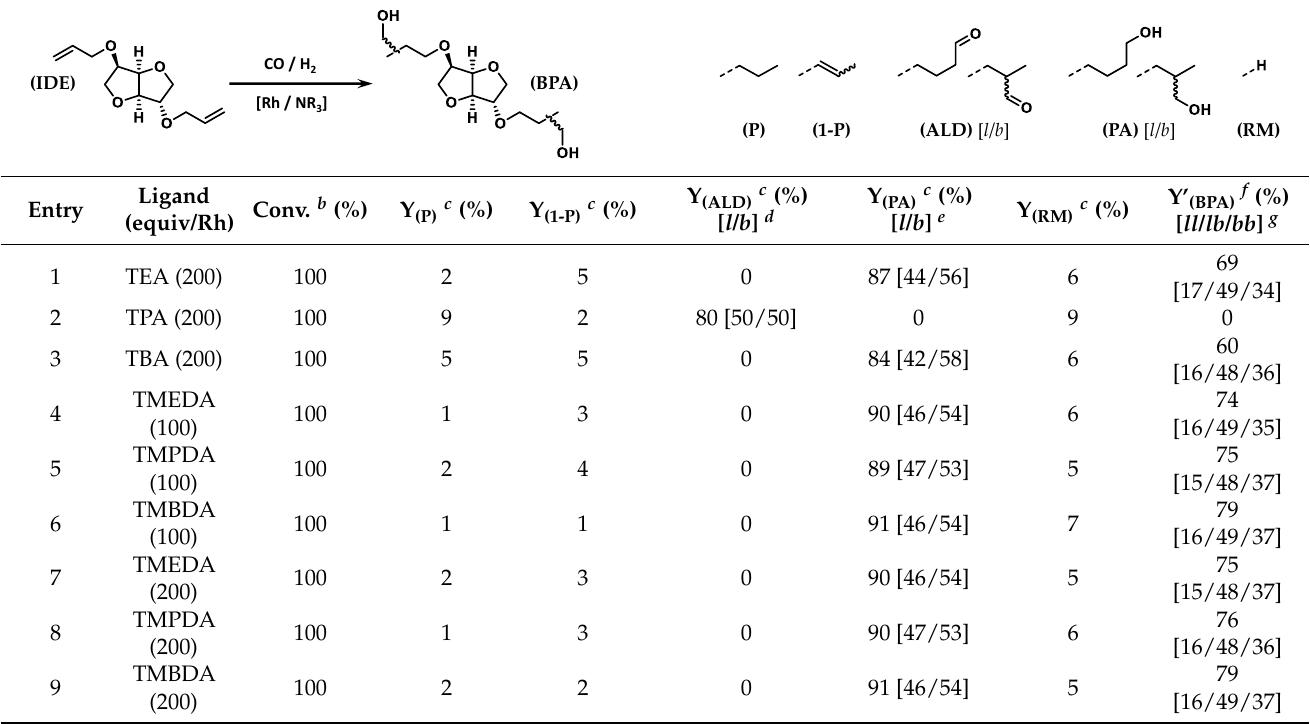
Table 2. Influence of the nitrogen compound nature on IDE hydrohydroxymethylation a . Table 1. Influence of the TEA amount on IDE hydrohydroxymethylation